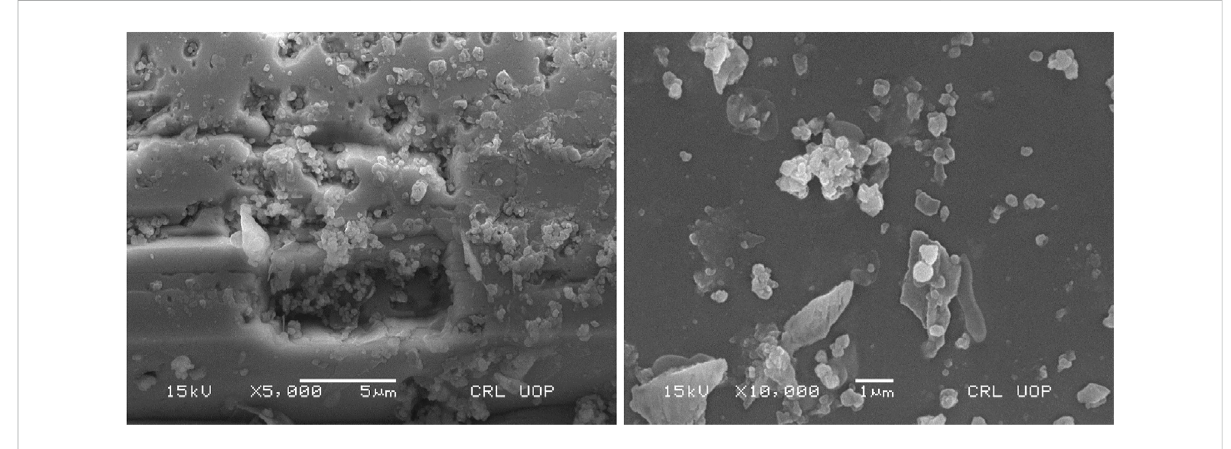
FIGURE 3 SEM images of the green synthesized chromium oxide nanoparticles.